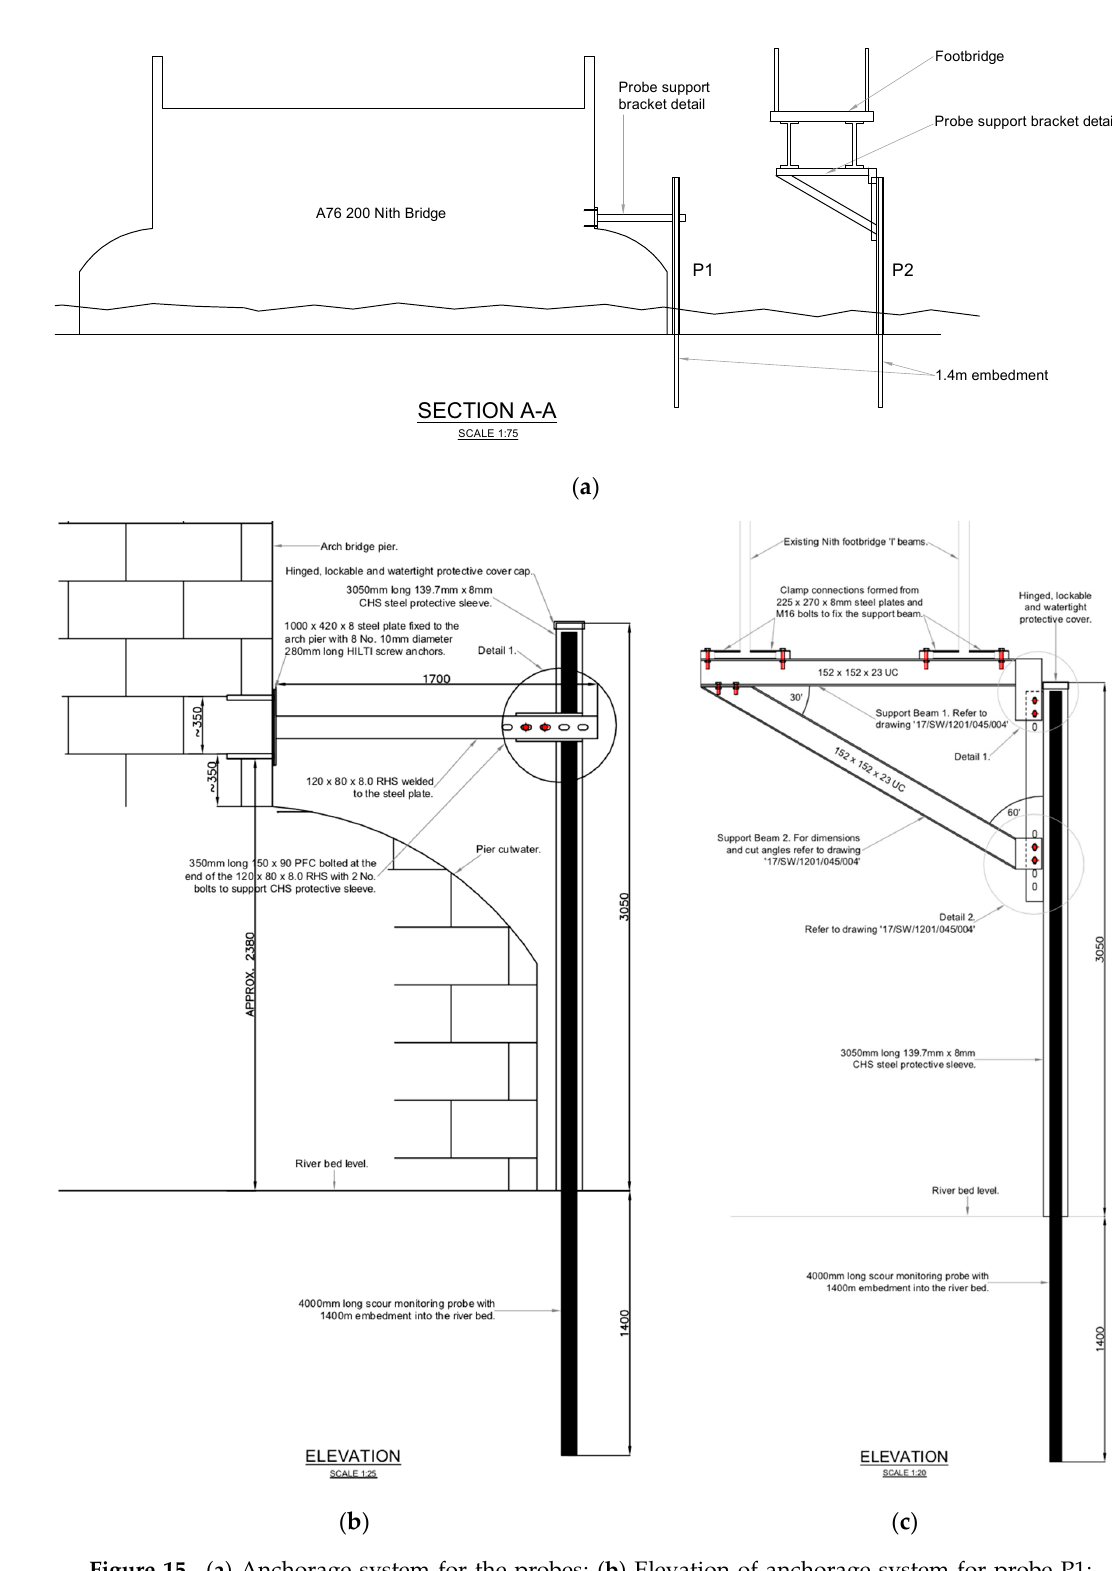
Figure 15. ( a ) Anchorage system for the probes; ( b ) Elevation of anchorage system for probe P1; ( c ) Elevation of anchorage system for probe P2. ( c ) Elevation of anchorage system for probe